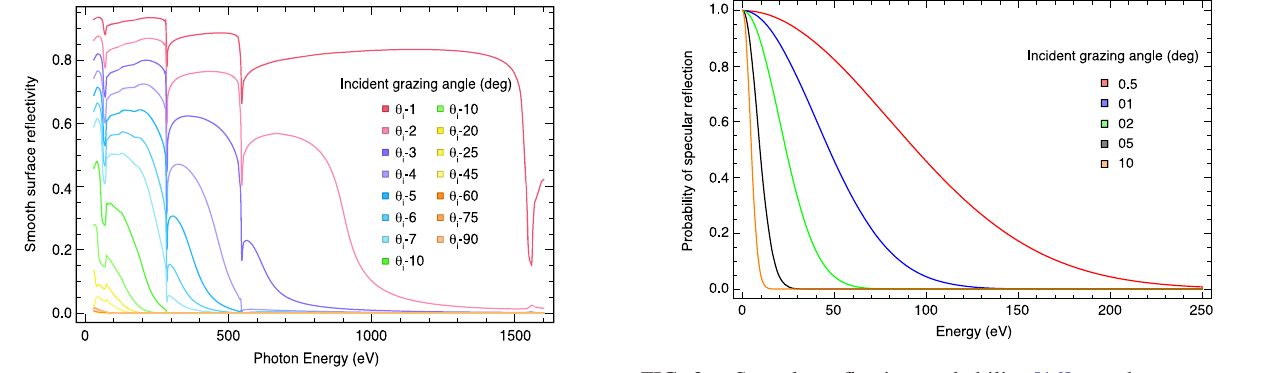
FIG. 1. Smooth surface reflectivity for a 5 nm CO film on an Al substrate: from [15].